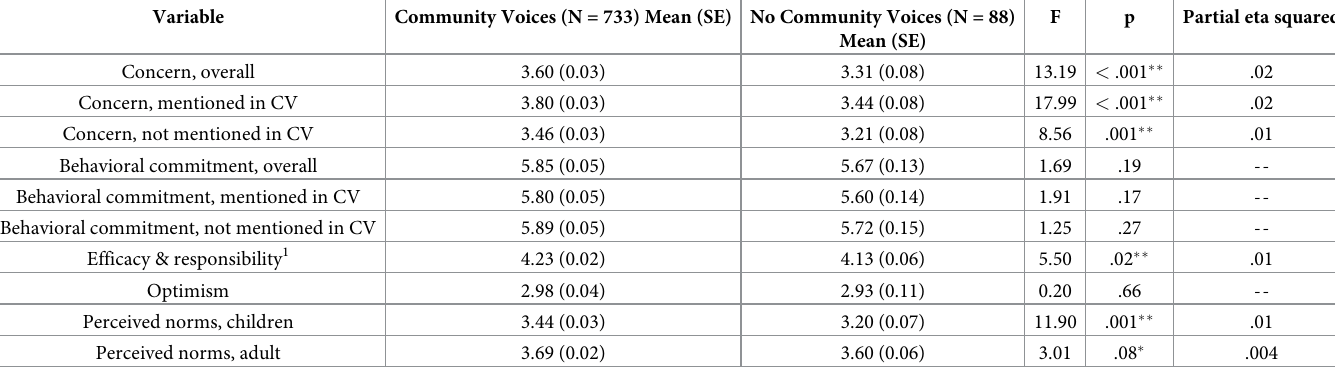
Table 2. Adjusted means (controlling for CNS and political orientation), SEs, and F statistics comparing exposure to community voices vs no exposure.